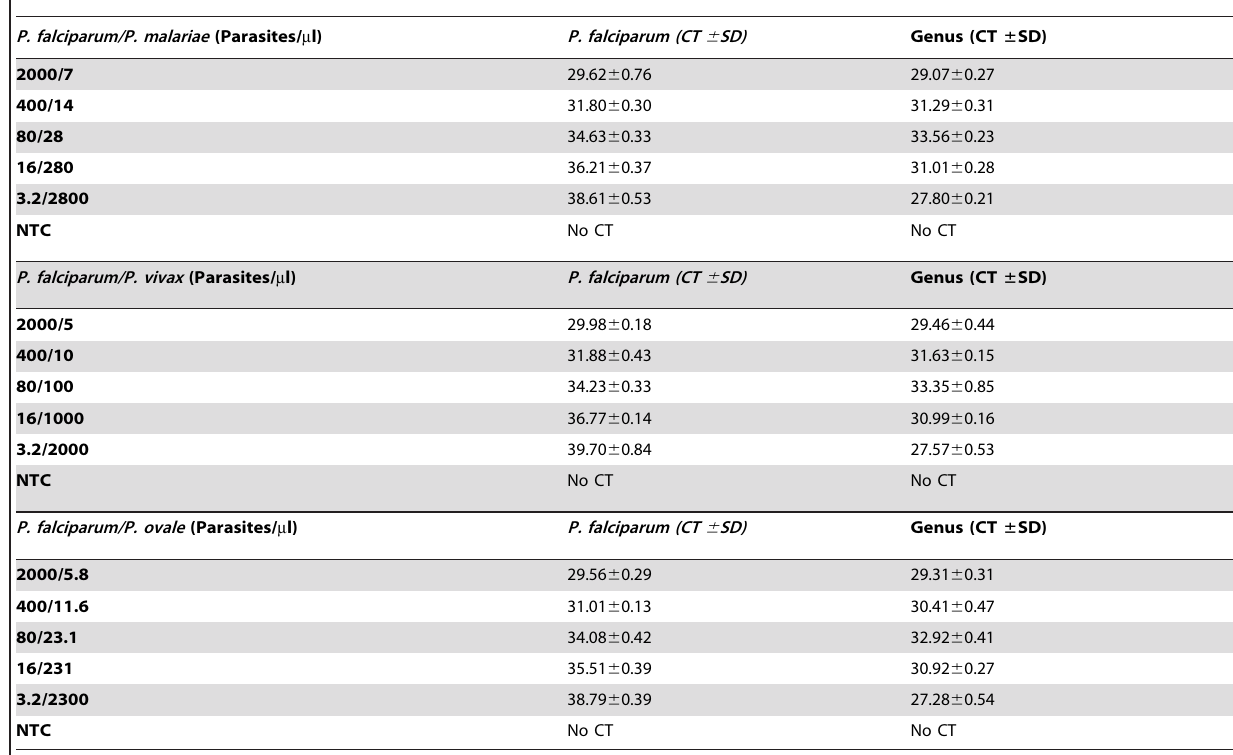
Table 3. Detection of mock mixed infections using the multiplex assay.